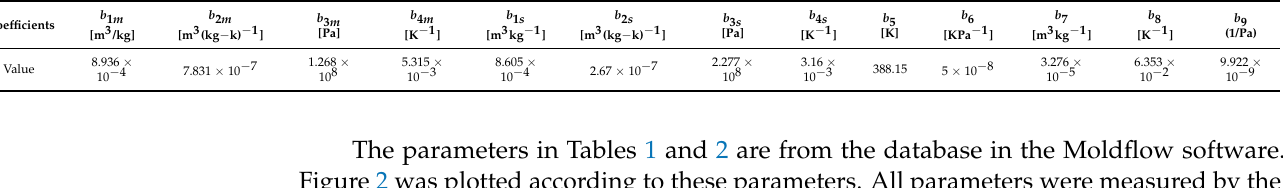
Table 2. The modified 2-domain pvT model coefficients in Equation (7).